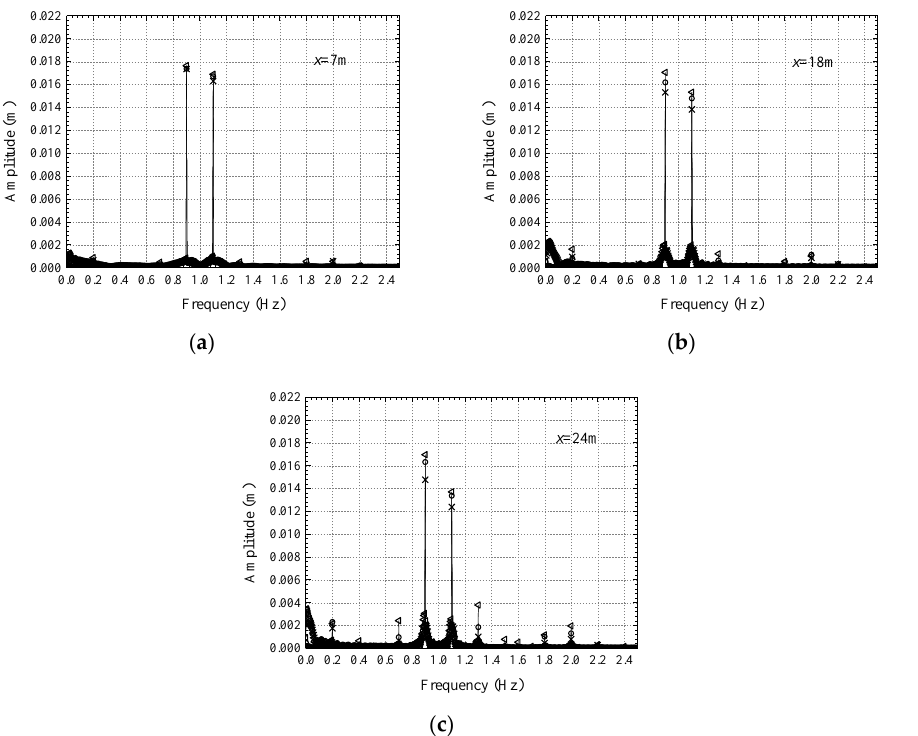
Figure 21. Frequency domain plots of wave simulation results at three points x = 7 m ( a ), 18 m ( b ), and 24 m ( c ) of MIKE 21 BW model with dual-frequency wave in downstream ( × ) no-current ( and counter-current ( ∆